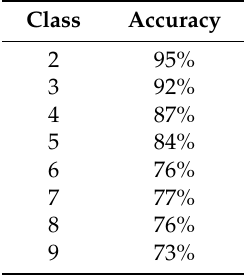
Table 4. The prediction accuracy of long cycle maintenance